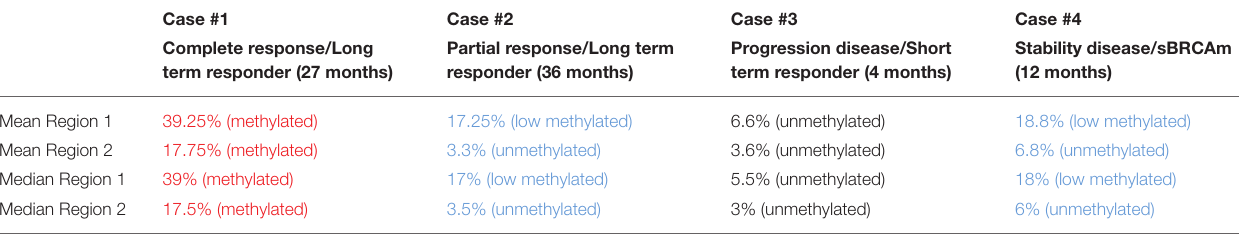
TABLE 3 | Percentages of methylation in each sample with means and medians in Region 1 and Region